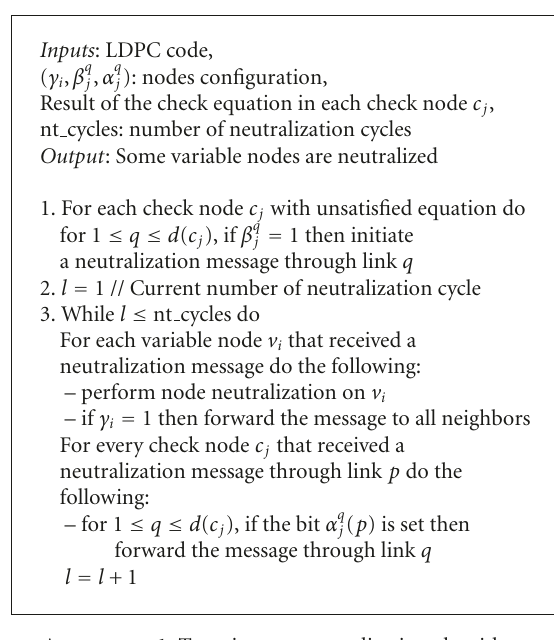
Algorithm 1: Trapping sets neutralization algorithm.